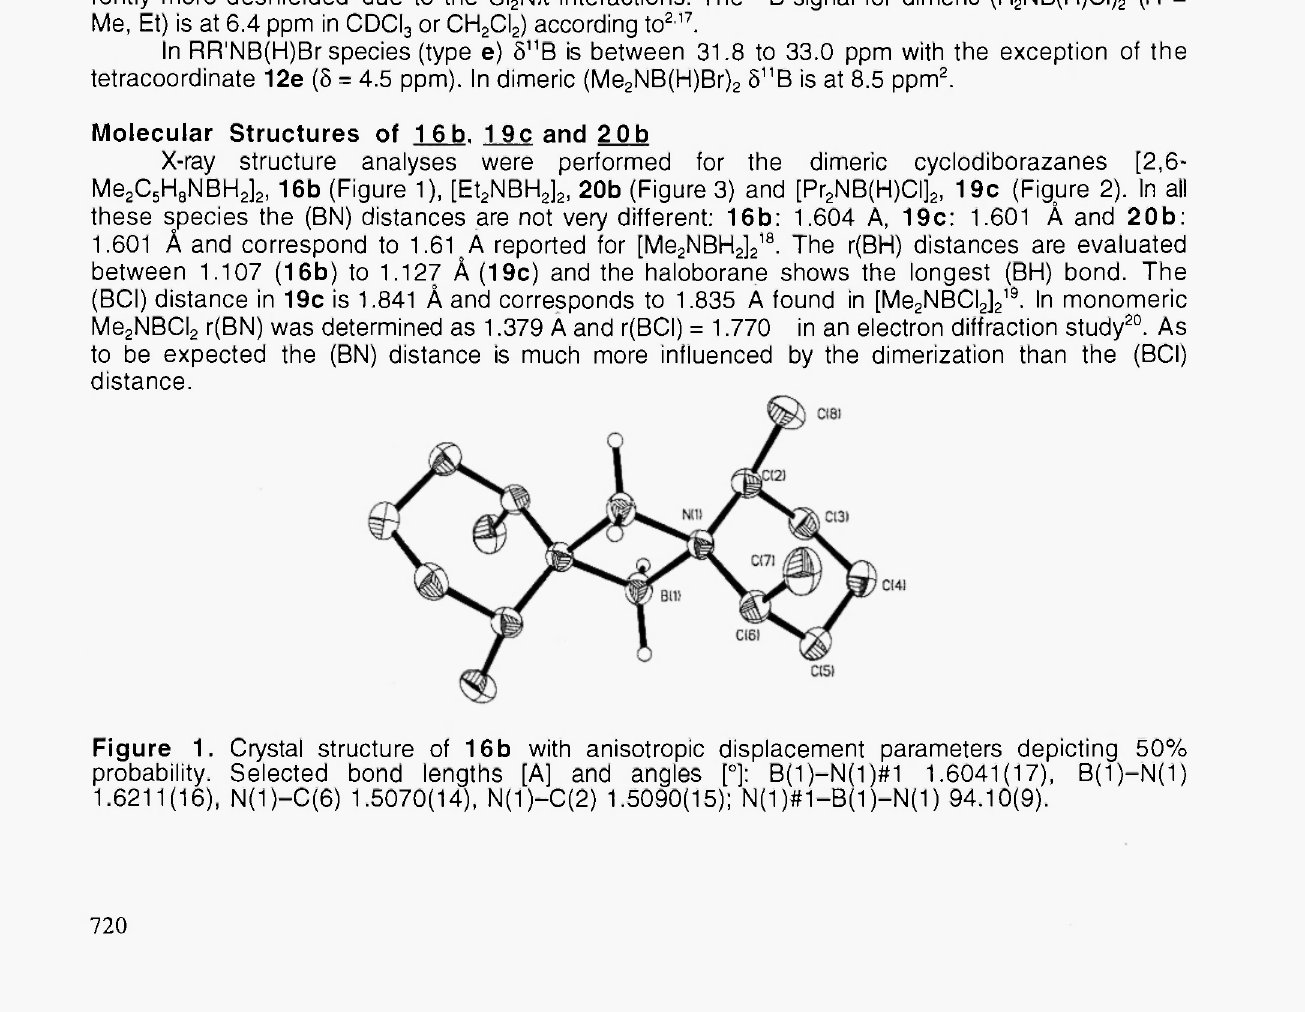
Figure 1. Crystal structure of 16b with anisotropic displacement parameters depicting 50% probability. Selected bond lengths [A] and angles [°]: B(1)-N(1)#1 1.6041(17), B(1)-N(1) 1.6211(16), N(1 )-C(6) 1.5070(14), N(1)-C(2) 1.5090(15); N(1)#1-B(1)-N(1)